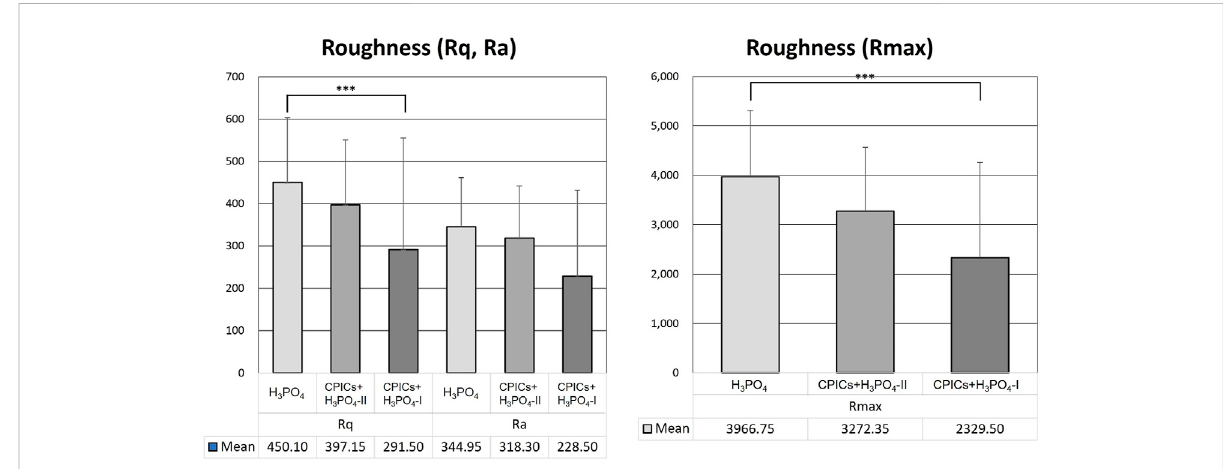
FIGURE 12 Roughness values of acid-etched enamel. This fi gure presents the data in Table 5. Error bars represent the standard deviation of the mean. *** indicates signi fi cance at p <